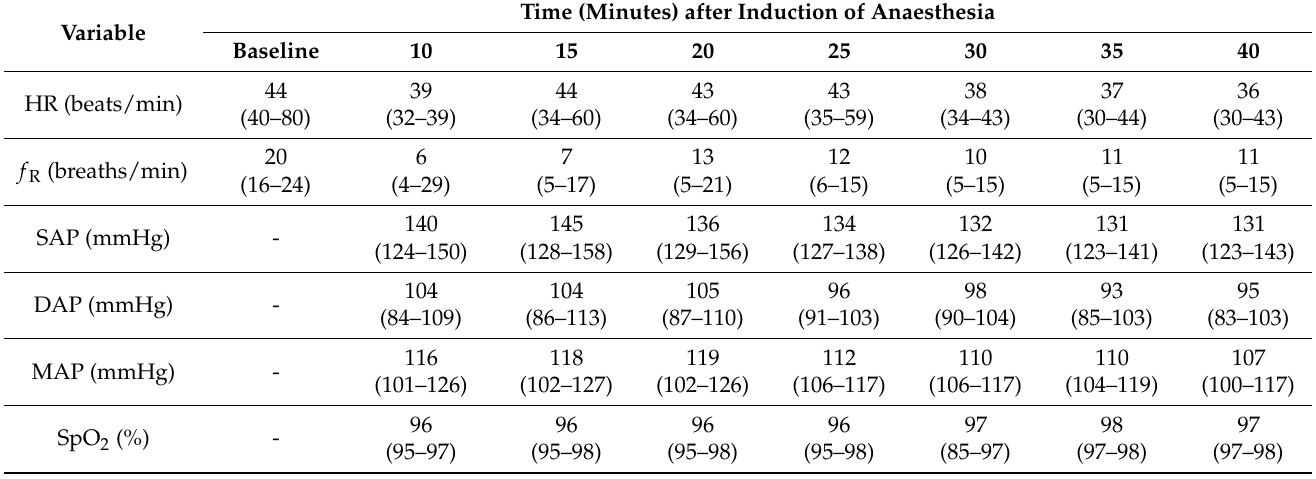
Table 1. Cardiorespiratory variables for five colts anaesthetised for 40 min with infusions of ketamine, medetomidine and midazolam as part of a balanced anaesthetic technique for surgical castration.